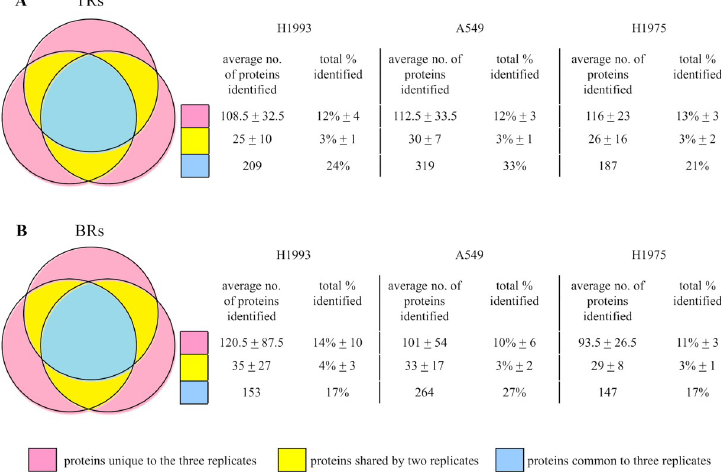
Fig 2. Venn diagrams and tables showing the average number of proteins (in total and in percentage of the total) identified across three TRs and three BRs out of the total proteins detected in the three cell lines H1993 (886), A549 (976) and H1975 (879), respectively for (A) TRs (B) BRs. The proteins unique to the three replicates is shown in pink, the proteins shared by 2 replicates is shown in yellow, and the proteins common to three replicates is shown in